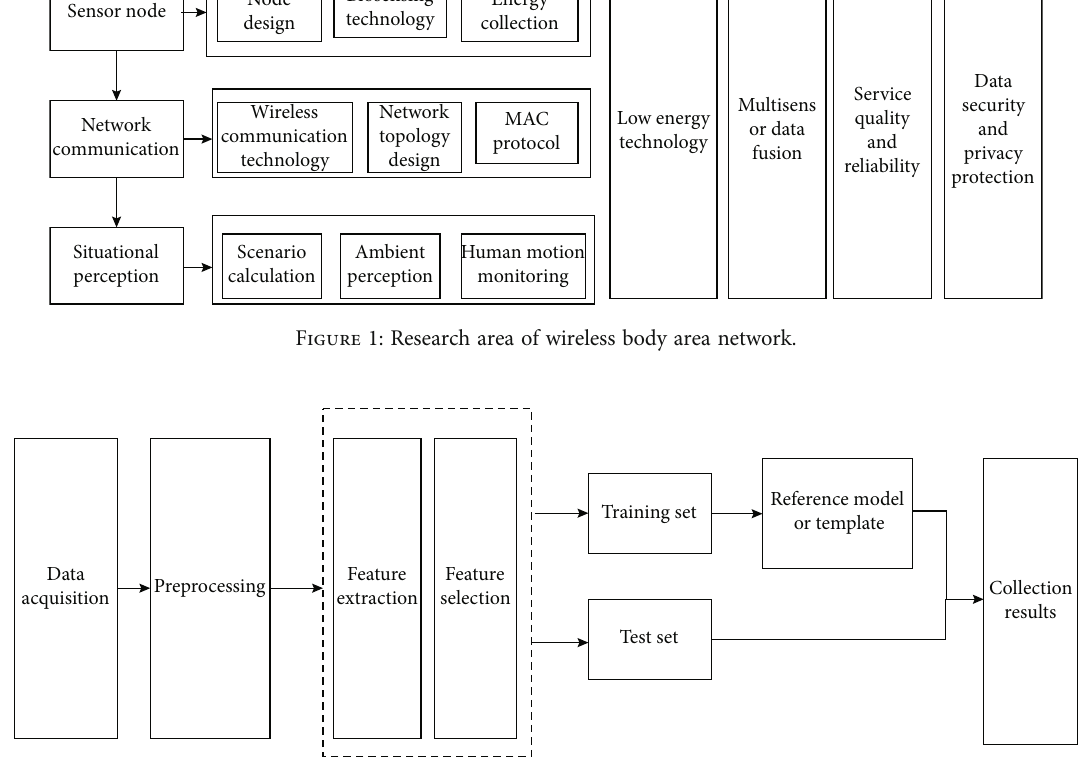
Figure 2: Multiperson target image sampling process of athlete training based on microinertial sensor.